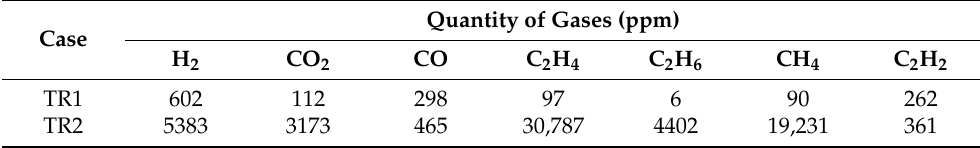
Table 11. Input gases (ppm) of TR1 and TR2.